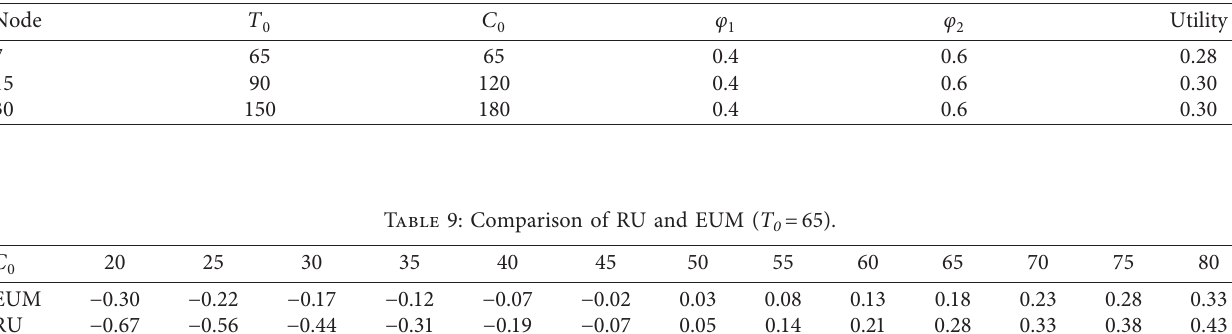
Table 10: Comparison of RU and EUM ( T